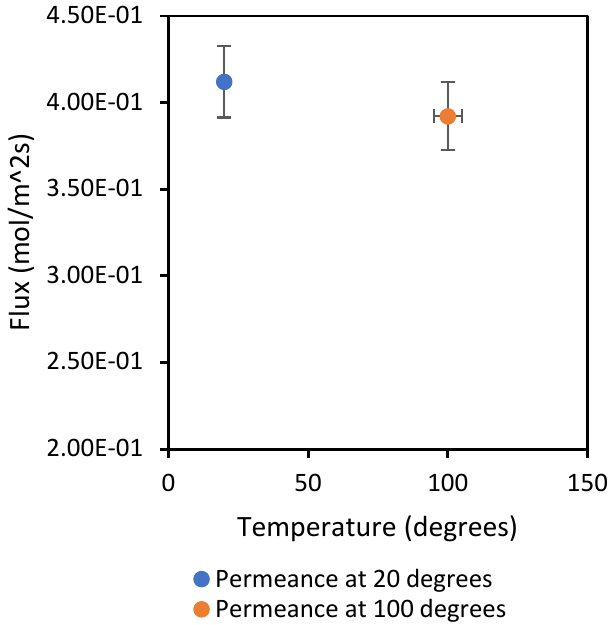
Figure 6. Effect of temperature on flux for CH 4 gas through 15 nm membrane at 1 bar.